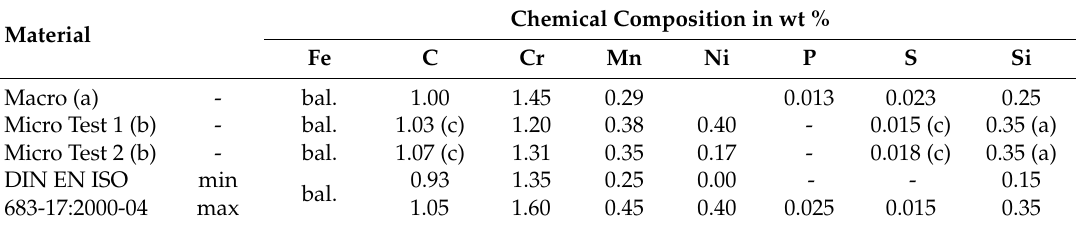
Chemical Composition in wt %